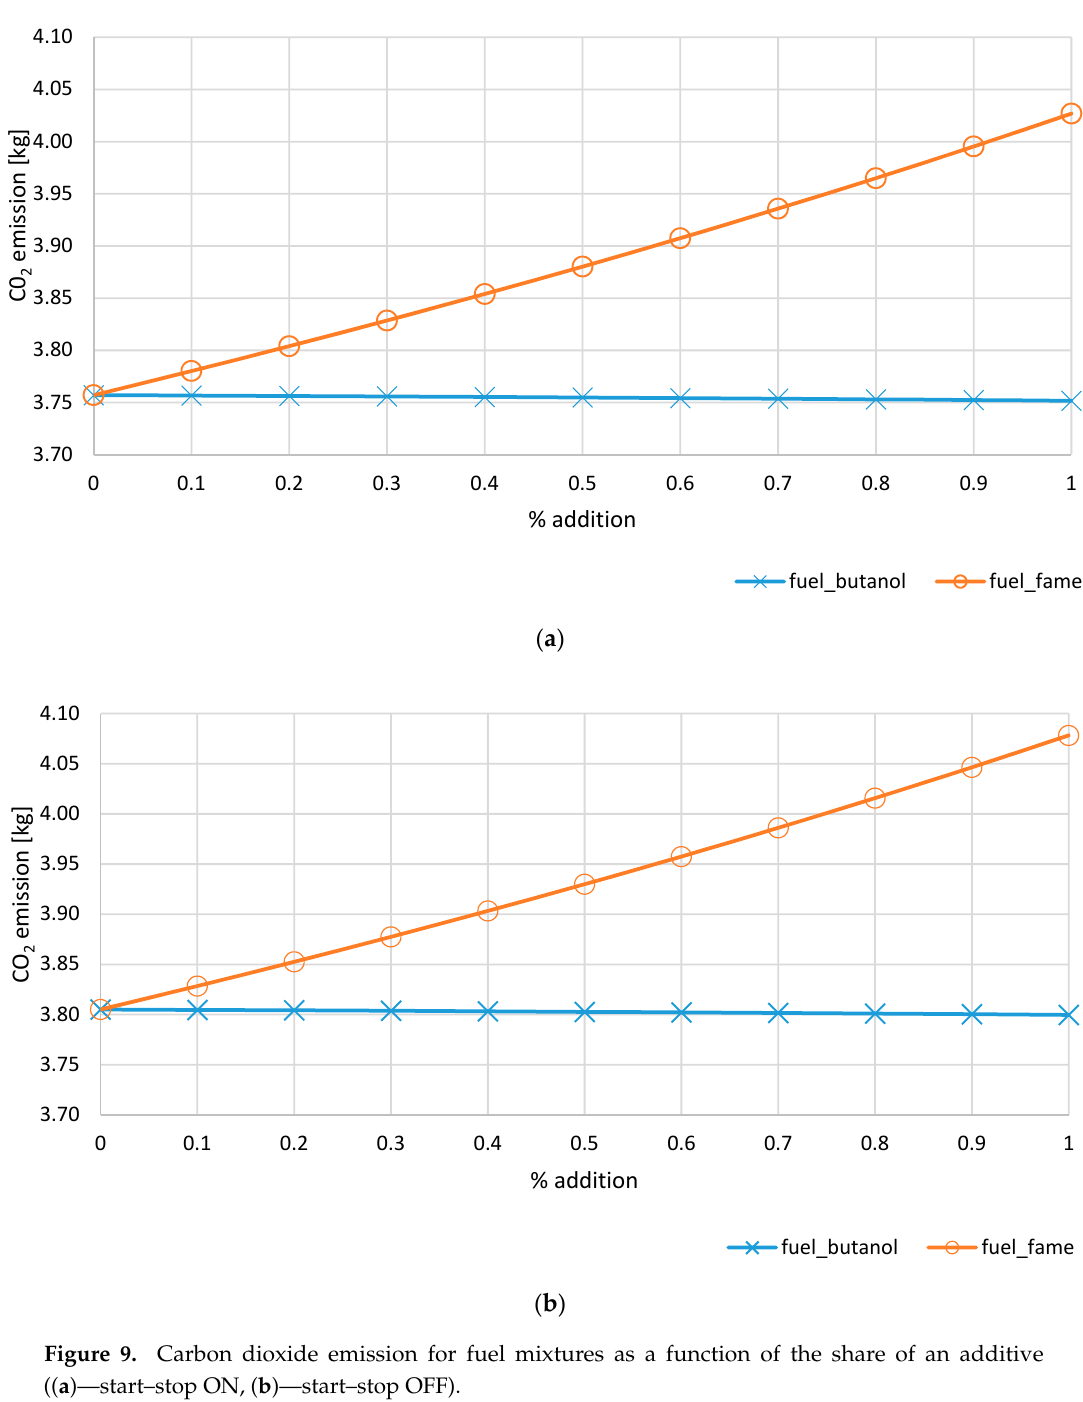
Figure 9. Carbon dioxide emission for fuel mixtures as a function of the share of an additive (( a )—start–stop ON, ( b )—start–stop OFF).